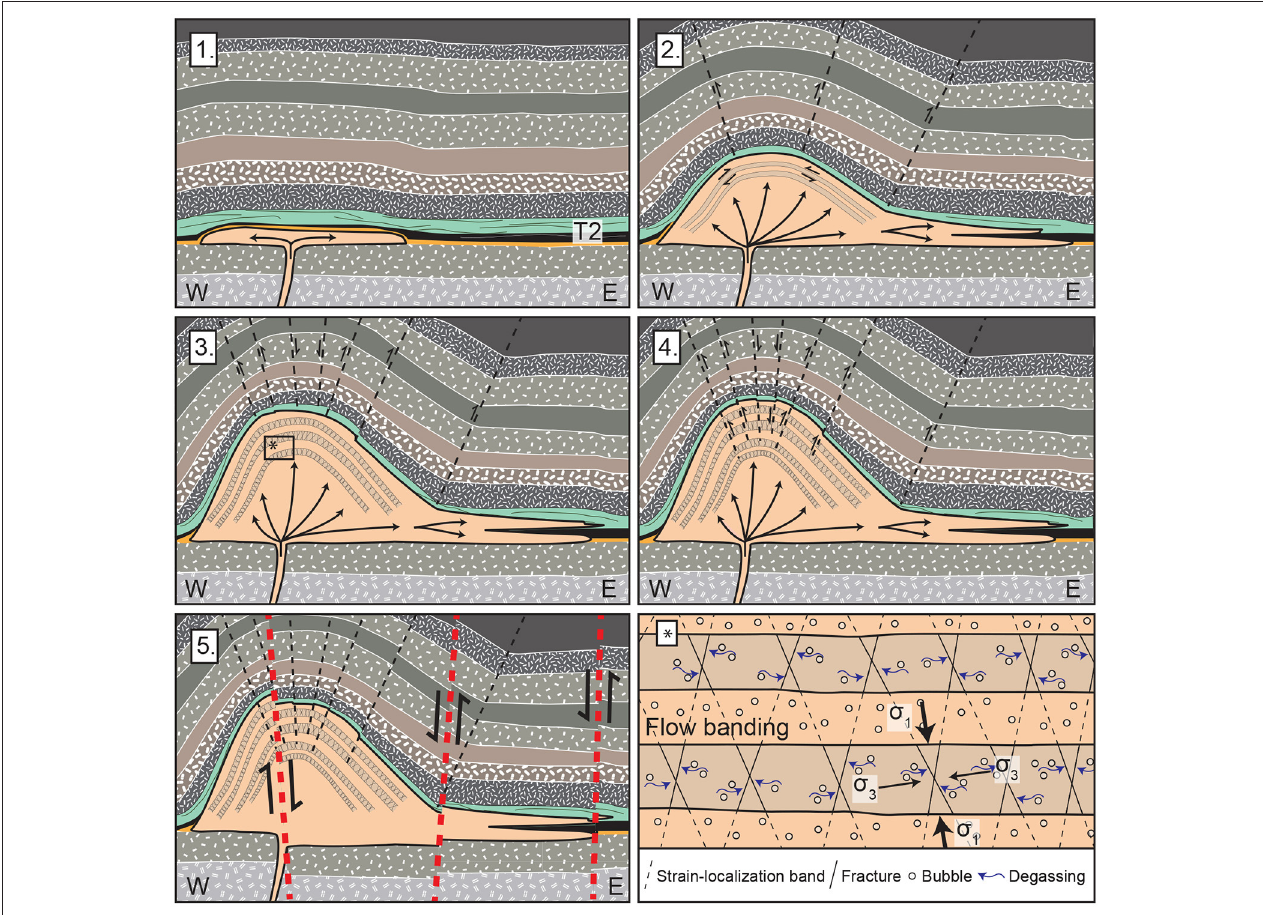
FIGURE 11 | (1) The formation of the Sandfell laccolith initiated as a sill intrusion (cf. Johnson and Pollard, 1973). (2) The sill started to inflate into a laccolith. Distinct flow banding formed by contact-parallel flow driven by push from intruding magma and shear due to magma body inflation. Two lobes of the rhyolite magma intruded at different stratigraphic levels of T2 to the east, forming Rauduhnausar and the Upper sill. (3) The inflation of the magma body continued, while the eastern lobes only marginally inflated. Viscosity increase in the magma was promoted by crystallization related to the flow banding and porosity reduction and compaction of the magma by the intrusive stress from continuously intruding magma (cf. Ashwell et al., 2015). During later stages of emplacement strain-localization fabrics developed in the magma (*). When subject to localized shearing, flow bands in the magma responded differently—some flow bands deformed in a brittle fashion and fractured, while other parts of the magma developed SLBs. Volatile exsolution and escape from the magma body where facilitated by decompression induced by fracture-band formation. This rapidly increased the viscosity of the magma aided by crystallization and porosity reduction and essentially solidified the rim of the laccolith. The tilted acute bisector planes of the conjugate fractures bands are probably attributed to minor shear during and after fracture-band formation. (4) The solidified part of the Sandfell laccolith was faulted and deformed by the still intruding magma in a similar fashion as the host rock, as evident by internal larger-scale faults, dipping